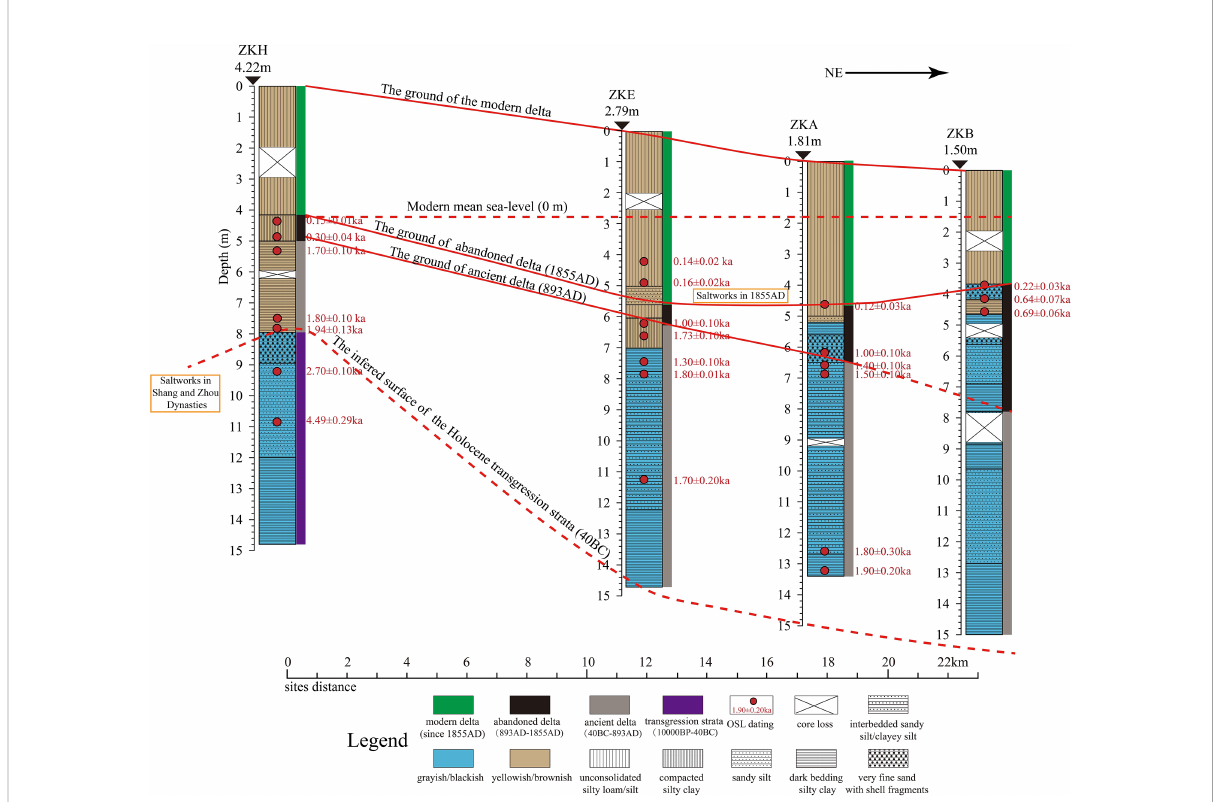
FIGURE 4 Correlation of the drilling cores using isochronic planes and the reconstructed geomorphology and sedimentary architecture of the shallow- buried abandoned Yellow River